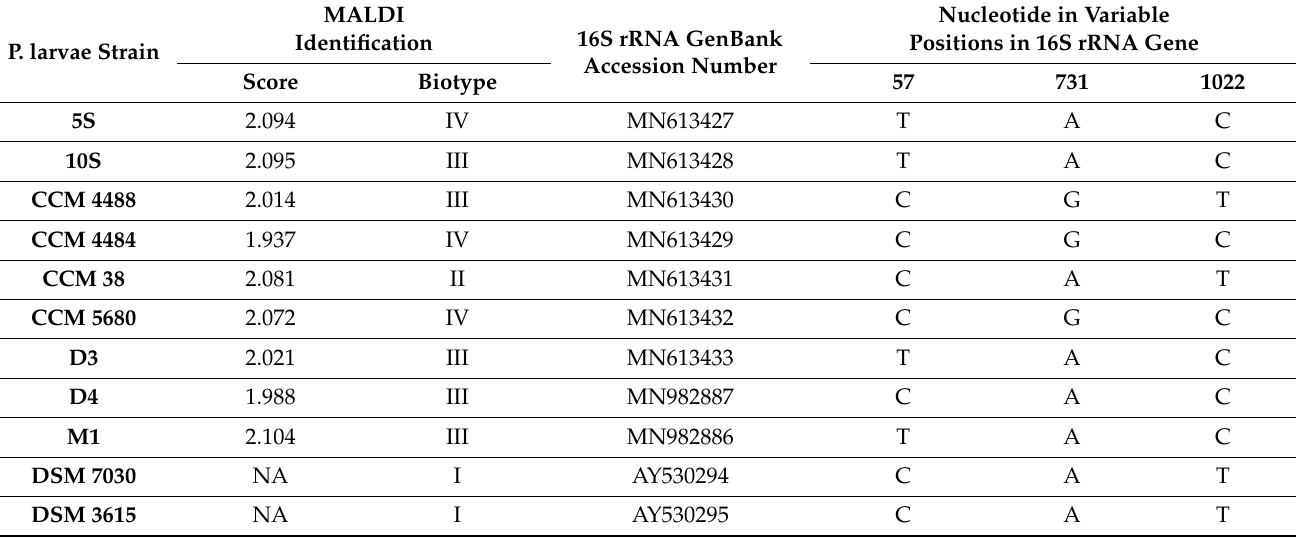
Table 1. MALDI-TOF identification and 16S rRNA sequence variability in P. larvae strains. Numbering according to P. larvae DSM 7030 sequence; NA: not